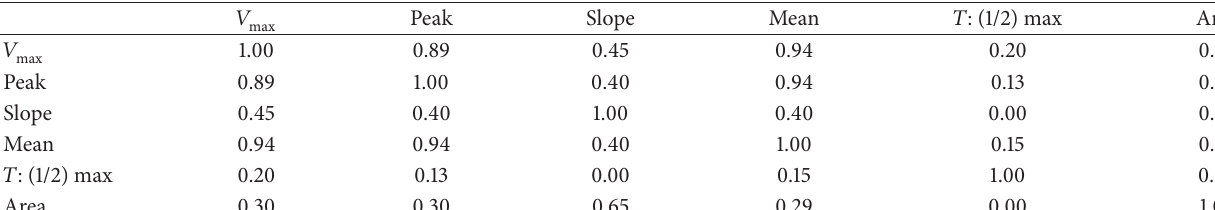
Table 5: RSQ values calculated for 10 𝜇 M of various kinetic parameters.